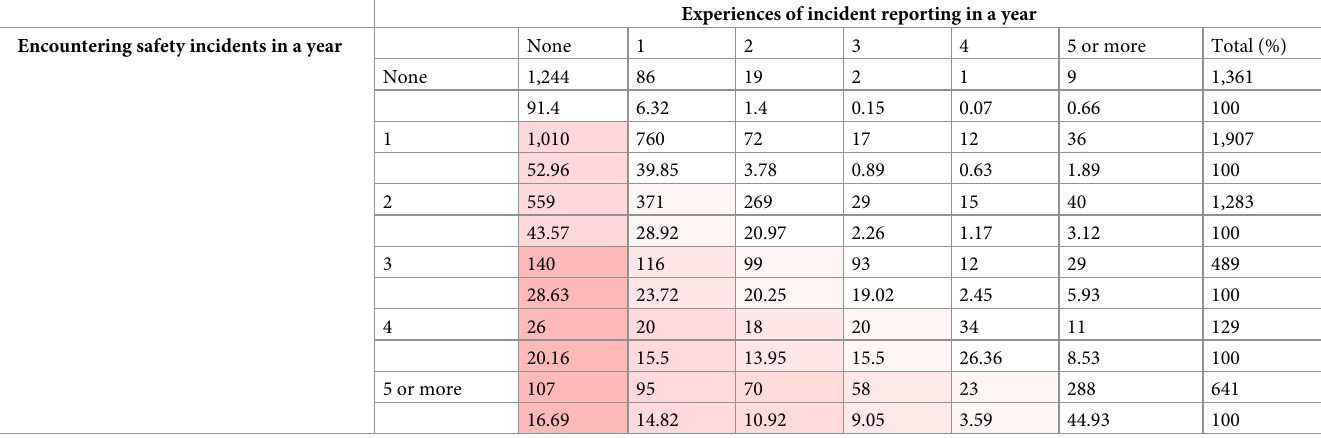
Table 2. Relationship between the experiences of incident reporting and encountering incidents in a